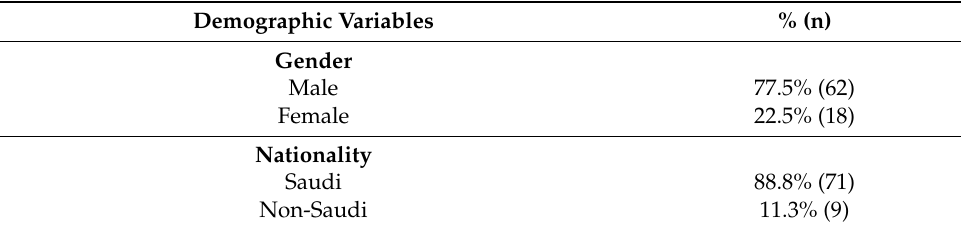
Table 1. Participants’ demographic data ( n =